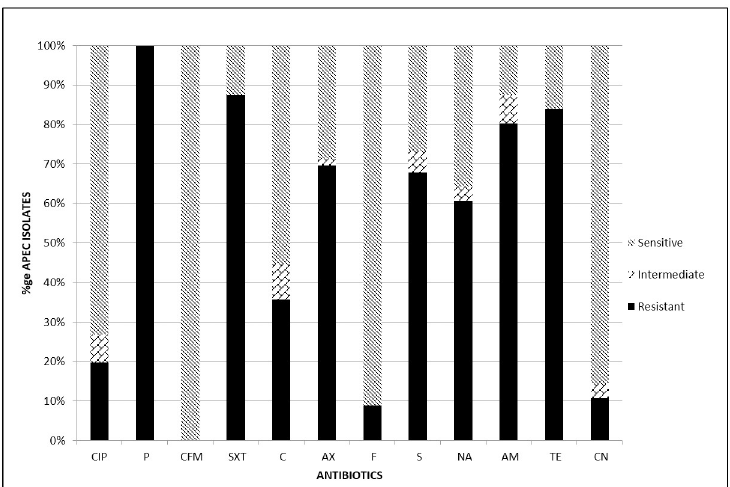
Fig 1. Antimicrobial susceptibility test results for avian pathogenic E . coli . The bars represent the percentages of the 56 APEC isolates that were resistant, intermediate or susceptible to the 12 antibiotics as determined by the Disk diffusion method. CIP—Ciprofloxacin, P—Penicillin G, CFM—Cefixime, SXT—Sulphamethoxazole/Trimethoprim, C—Chloramphenicol, AX—Amoxillin, F—Nitrofurantoin; S—Streptomycin, NA—Nalidixic acid, AM—Ampicillin, TE—Tetracycline, CN—Gentamicin.